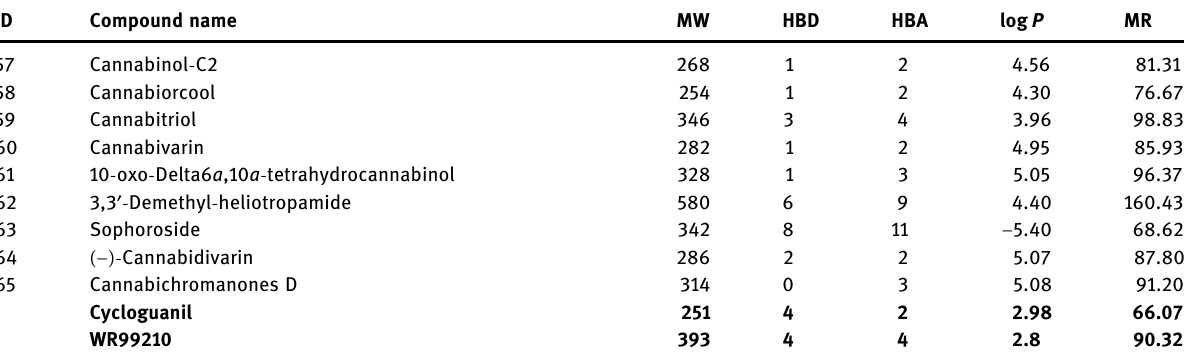
Table 2: Docking score results of 16 potential compounds on enzyme pfDHFR - TS